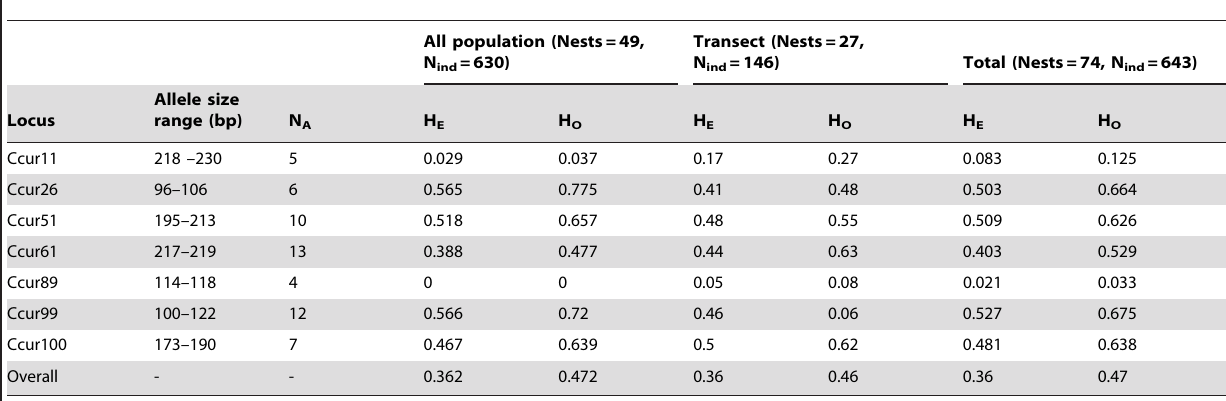
Allele size range (bp); N A , number of alleles; N ind , number of genotyped individuals; H E , expected heterozygosity; H O , observed heterozygosity. All population (Nests =49) refers to all nests genotyped from 2009 and 2010 (plot